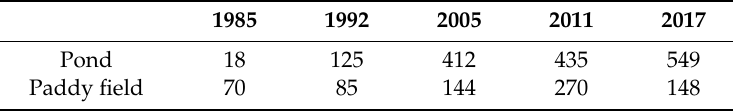
Table 3. Variation of altered wetlands in Nansi Lake (km 2 ).